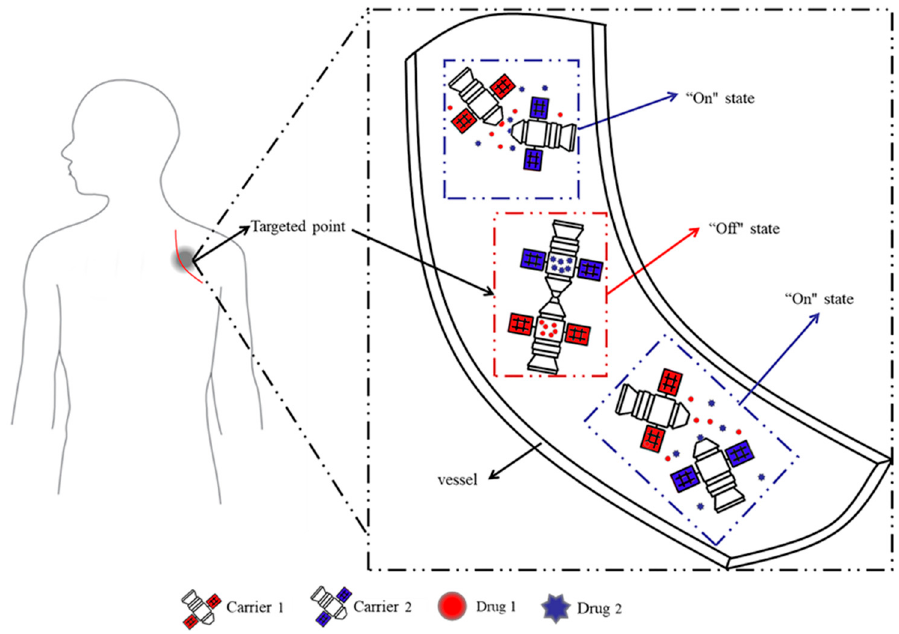
Figure 1. Design ideas of the proposed docking